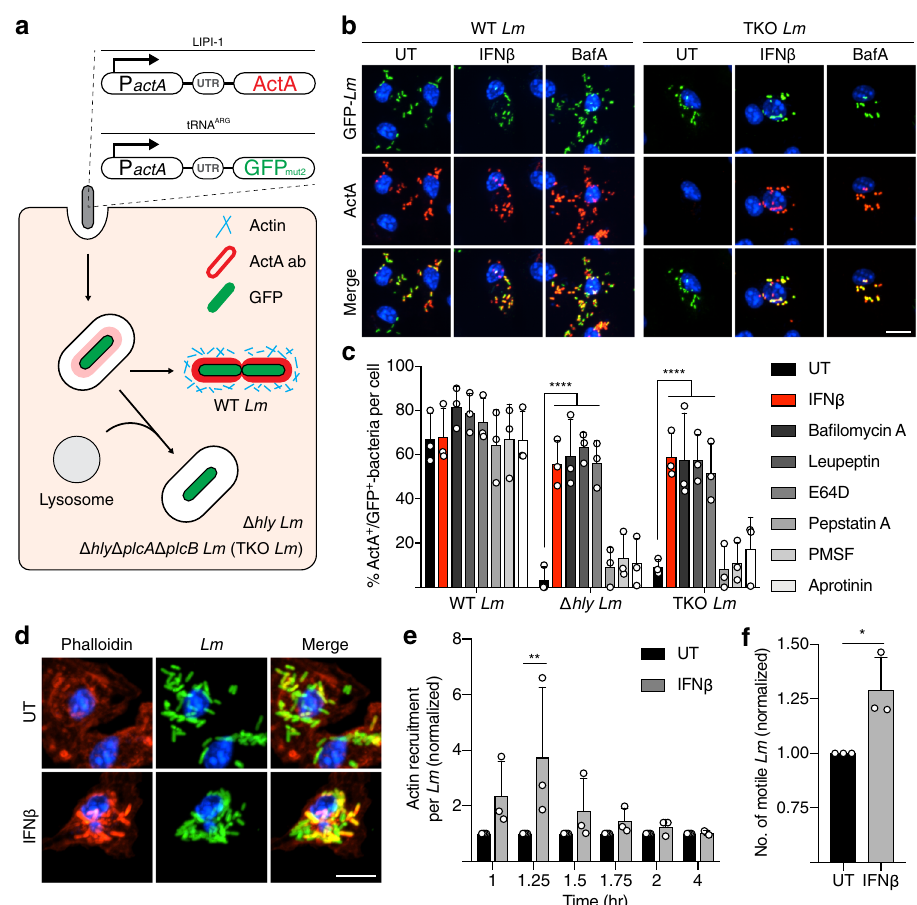
Fig. 3 Type I IFN suppresses ActA degradation in phagosomes and promotes Lm actin recruitment. a Schematic of GFP reporter Lm strains developed to measure actA transcription activation. Representative images ( b ) and quanti fi cation ( c ) of actA :GFP reporter expression and ActA degradation of BMDMs infected for 4h with indicated Lm strains measured by GFP fl uorescence and antibody staining, with or without treatment of IFN β , ba fi lomycin A or protease inhibitors. Representative images at 1.25hr p.i. ( d ) and quanti fi cation ( e ) of WT Lm actin recruitment, measured by phalloidin staining, after phagosome escape over 4h